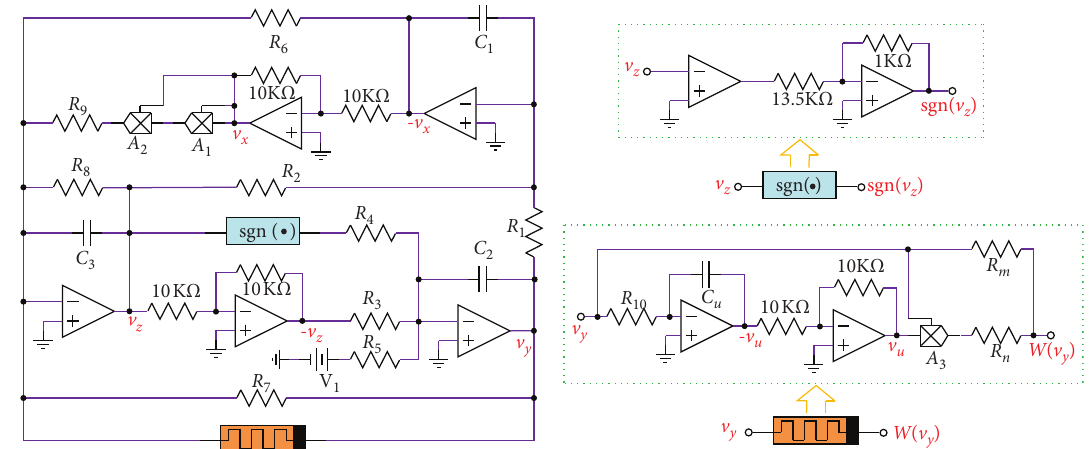
Figure 12: Circuit implementation of system (3).